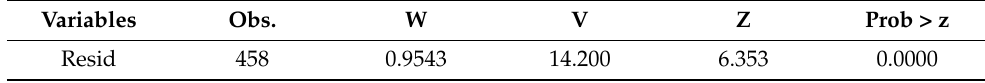
Table 4. Shapiro–Wilk W-test for normal data.